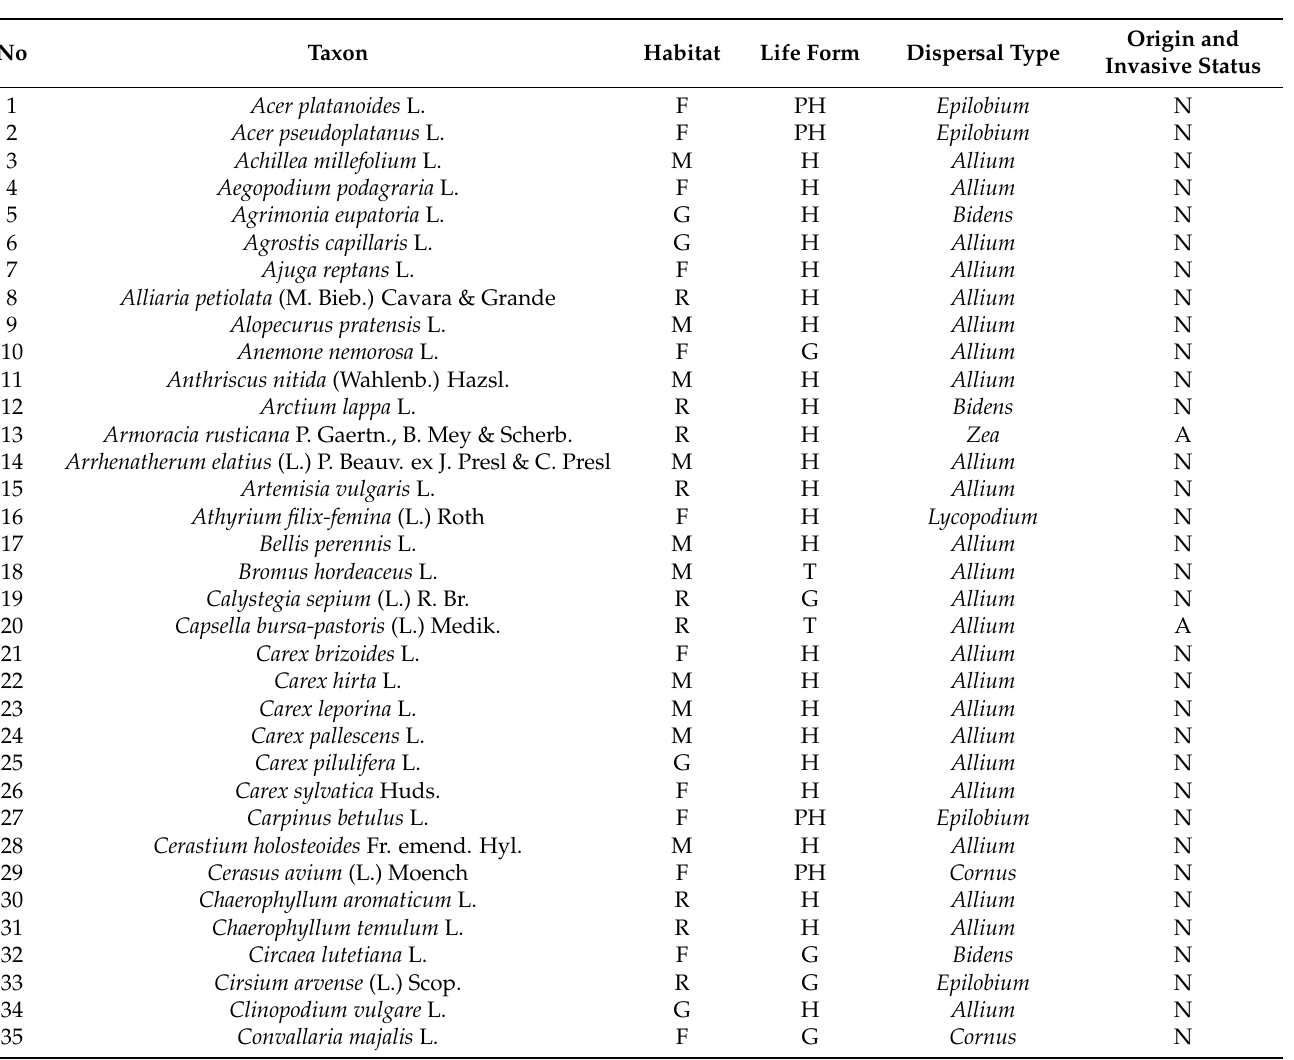
Table A1. The characteristics of species found in the plant cover of the studied deciduous forest undergrowth regarding habitat affiliations according to Matuszkiewicz [34], life form and dispersal type according to the Database of the Czech flora and vegetationPladias [32], and origin and invasive statusaccording to the Alien species in Poland database [35] and references